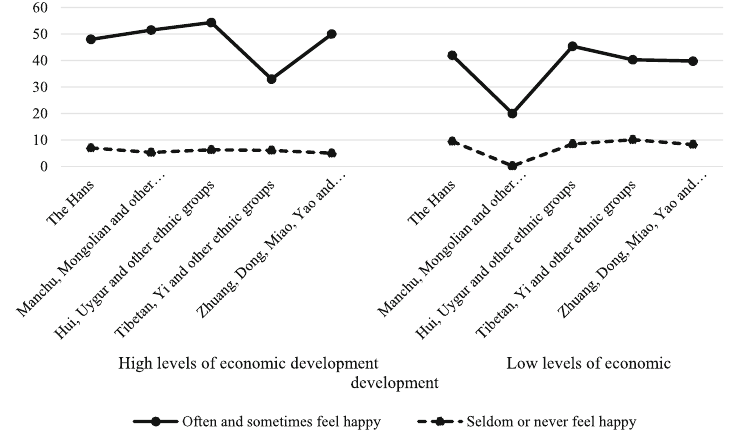
Fig. 3 Levels of regional economic development and subjective well-being of ethnic residents